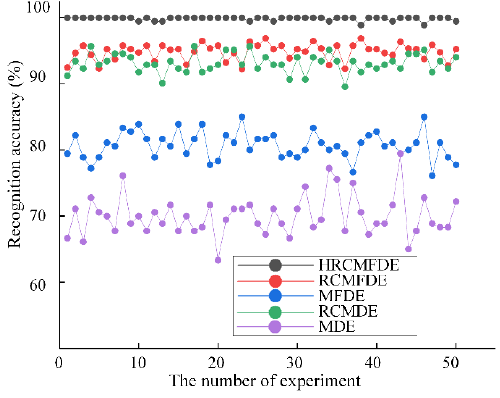
Figure 24. The accuracy of different approaches. Table 14. Comparison of models under different classification methods. Different Classification